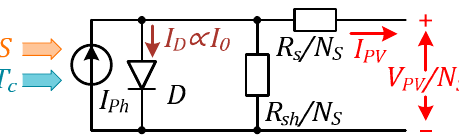
Figure 9. Single-diode model of a PV cell.